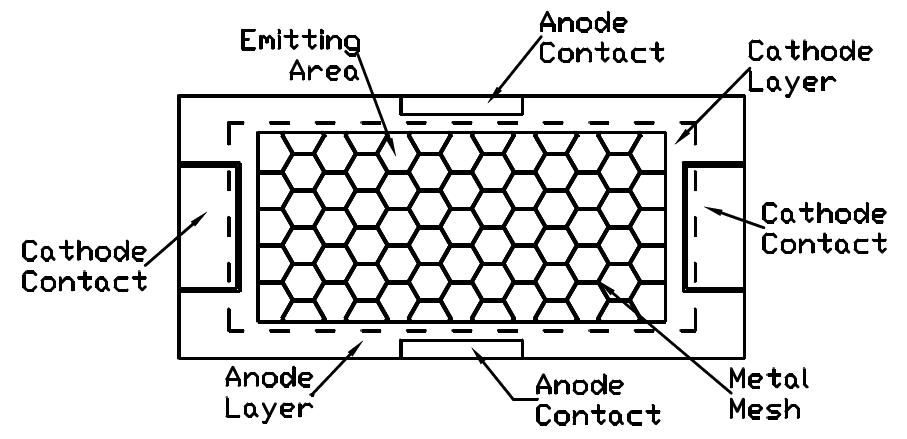
Figure 3. Traditional WOLED layout design.